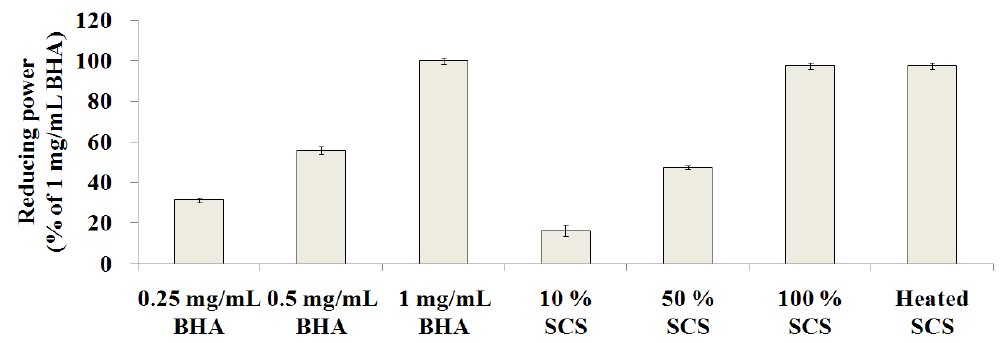
Figure 3. Reducing powers of standard samples and Lr-SCS samples.